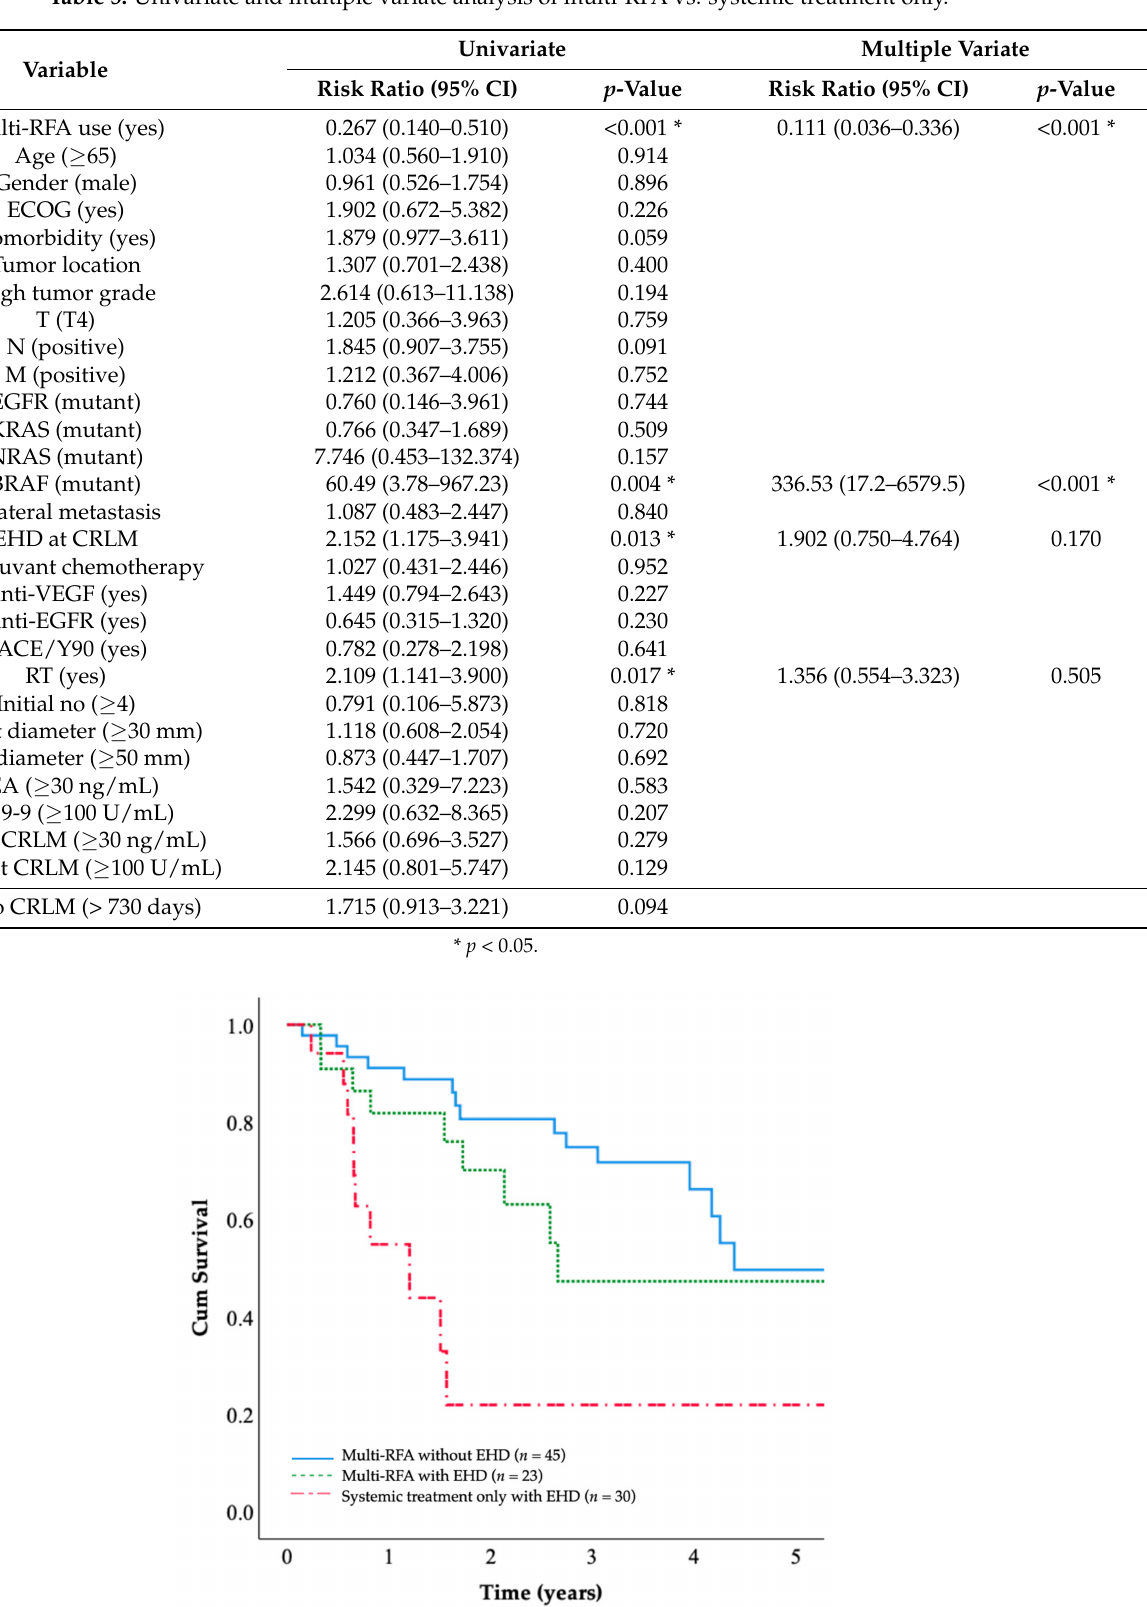
Table 5. Univariate and multiple variate analysis of multi-RFA vs. systemic treatment only.